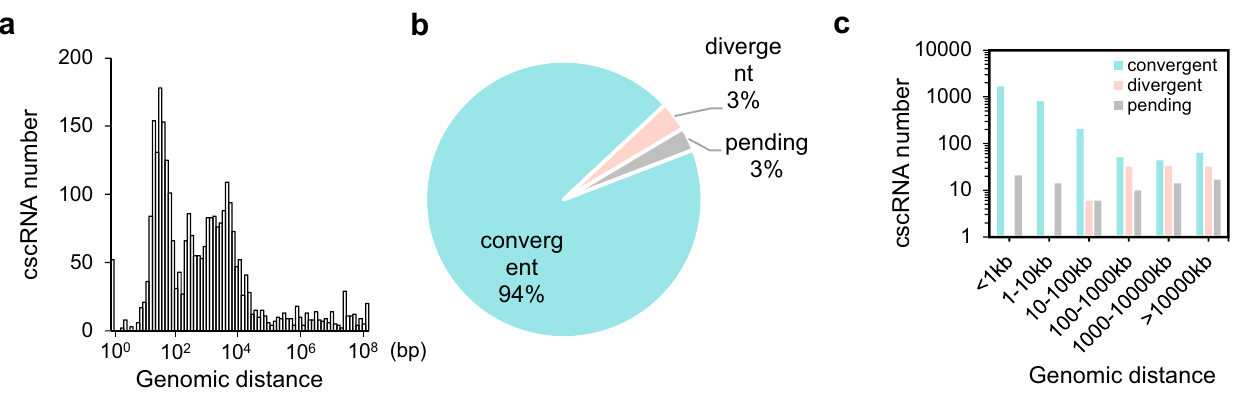
Fig. 5 Convergent transcription potentially giving rise to the cscRNAs. a Distribution of the genomic distances between each pair of the cross-strand junction sites of the recurrent cscRNAs. b Proportions of the recurrent cscRNAs that were originated from convergent transcription and divergent transcription, and the cscRNAs of which the originations were undetermined. c The cscRNAs were fi rst partitioned into different groups based on the genomic distances between the cross-strand junction sites. Within each group, the proportions of the recurrent cscRNAs in the 3 categories introduced above were shown on the